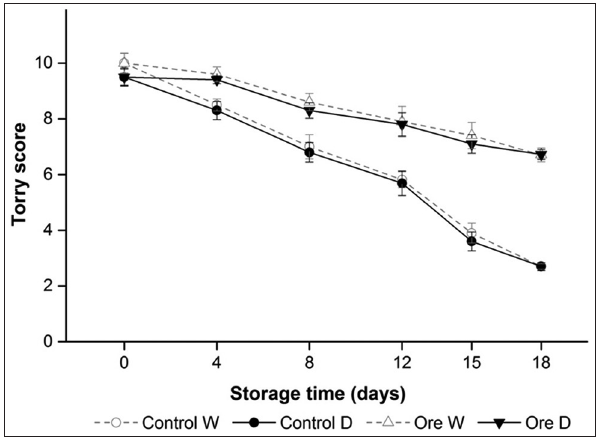
Figure-2: Sensory score of cooked dark (D) and white (W) muscle from frigate tuna fillet during refrigerated storage under vacuum pack: Untreated (control), oregano extract (Ore). Mean scores of sensory assessment (n=6). Standard deviations are indicated by bars. The limit of acceptability was defined by panelists as score of